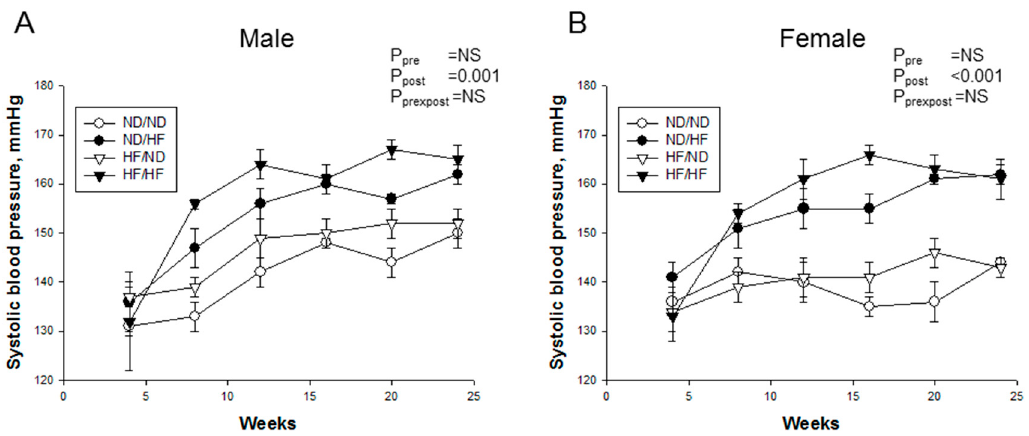
Figure 2. Effects of maternal and postnatal high-fat (HF) diet on systolic blood pressure in: ( A ) male; and ( B ) female offspring from four to 24 weeks. Pre × Post, interaction of pre × post; NS, not significant; N (pups/L) = 5-7/3 per group.